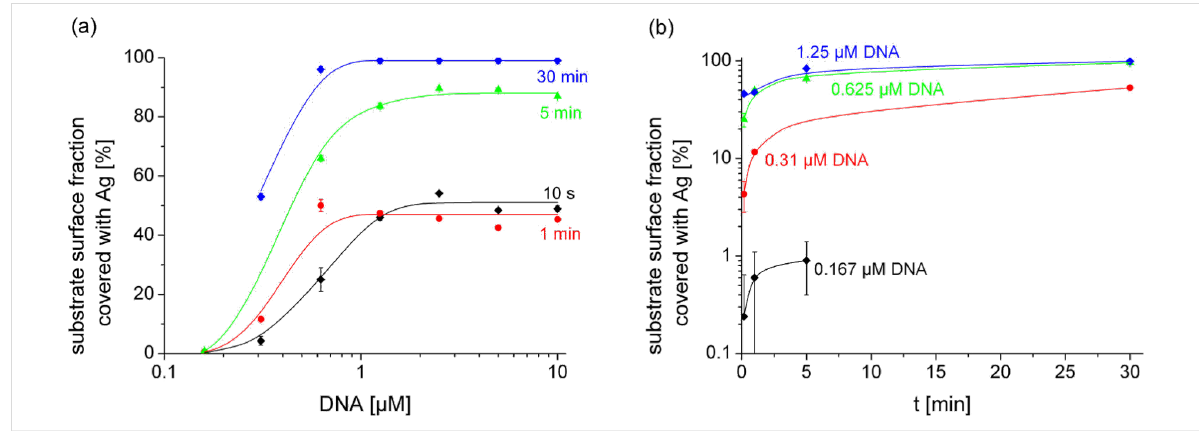
Figure 4: Fraction of the substrate surface covered by silver nanoparticles obtained by grey-tone analysis of SEM images (analysed field size: 12 × 9 µm 2 ) in dependence on (a) the initial concentration of DNA with the time of synthesis as a parameter and (b) time of particle growth with the DNA concentration as a parameter. Hidden error bars are too small to be displayed on the chosen axis scale. The curves are only a guide for the eye. Please note the differently scaled ordinates.